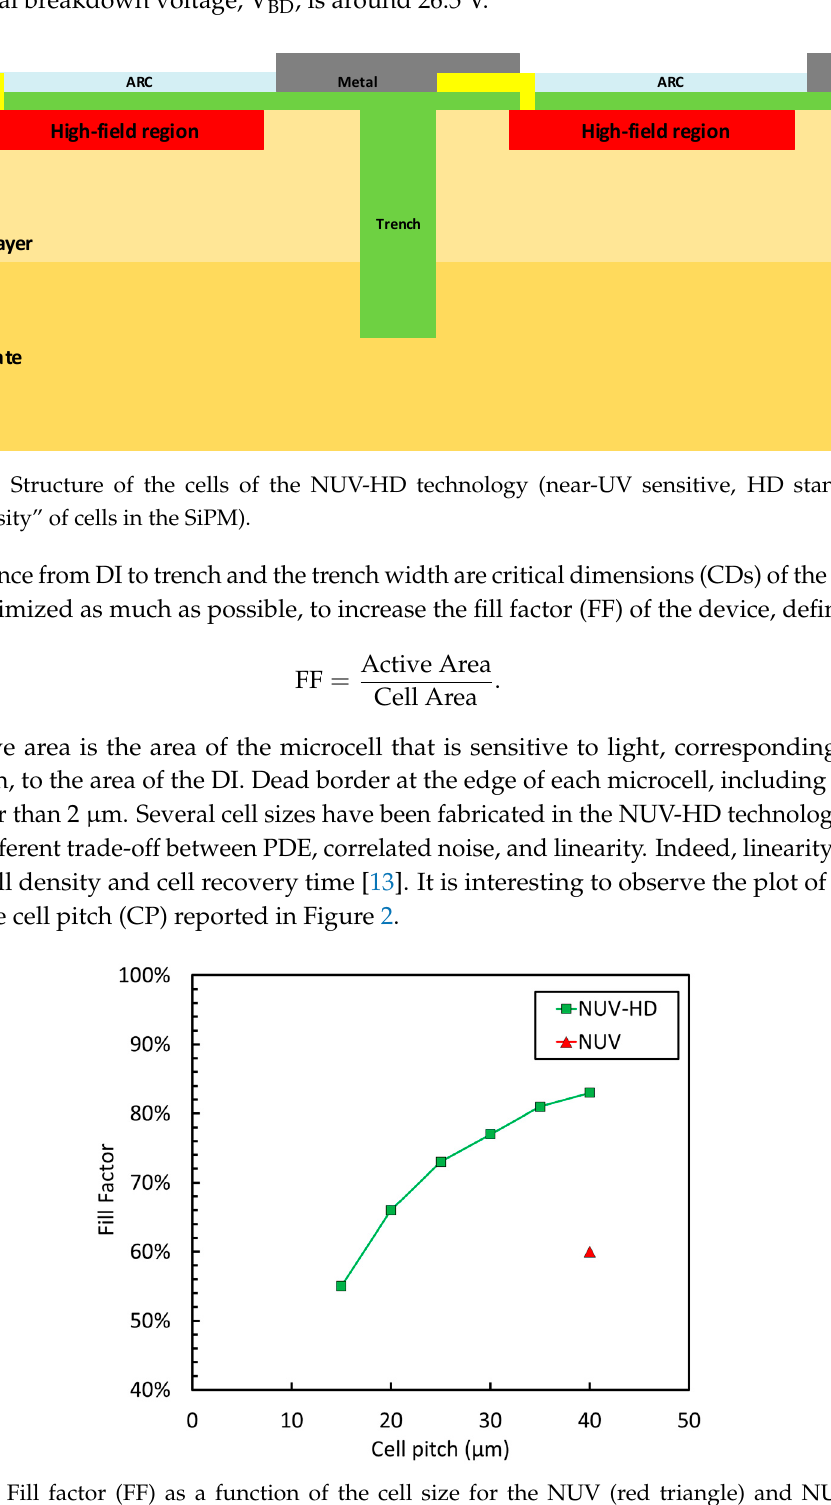
Figure 2. Fill factor (FF) as a function of the cell size for the NUV (red triangle) and NUV-HD (green squares) technologies.